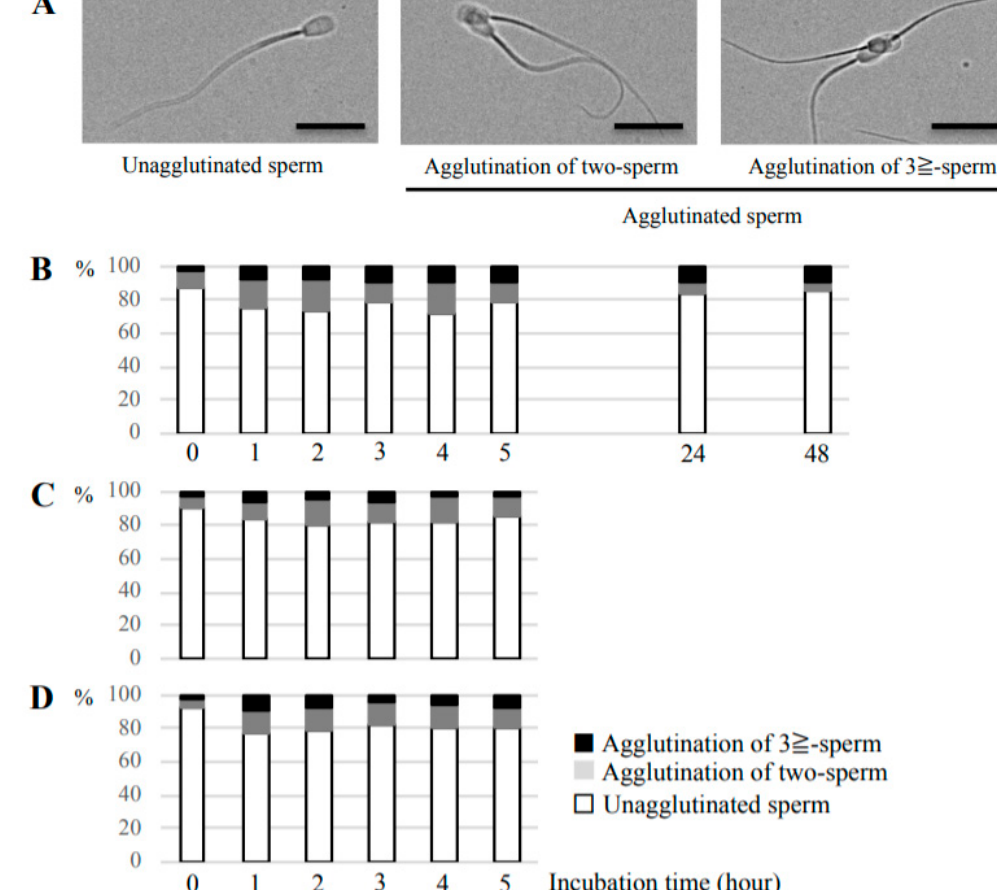
Figure 1. Temporal changes of head-to-head agglutination of bovine sperm. ( A ) Representative images of agglutinated and unagglutinated sperm. Left: image of single unagglutinated sperm; Middle: agglutination of two-sperm; Right: agglutination of ≥ 3 sperm. Bars = 20 μ m. ( B – D ) The agglutination rate of bovine sperm was examined at 0, 1, 2, 3, 4, 5, 24, or 48 h after incubation in non-capacitation medium ( B ) or capacitation medium ( C , D ). The result of the sperm suspension derived